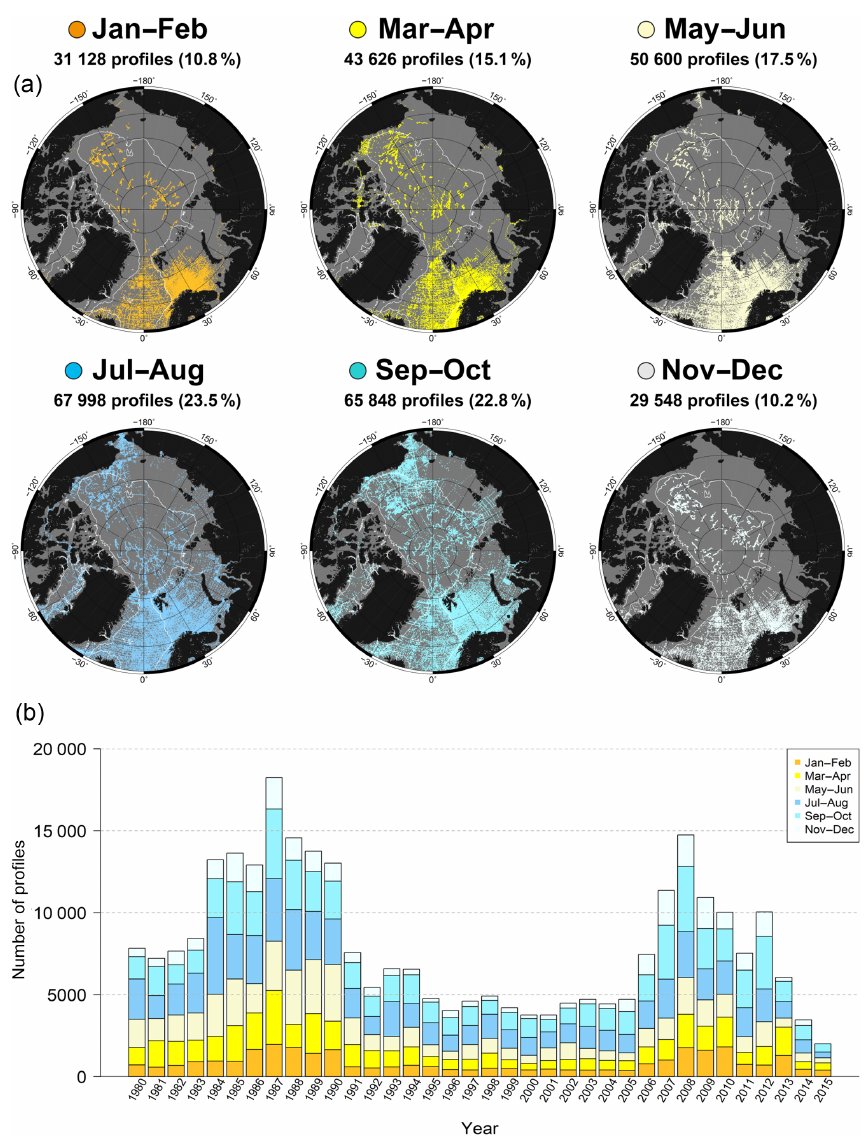
Figure 13. (a) Distribution maps of profiles in different 2-month periods. The white line is the 500m isobath. The fraction of the full data set is shown as percentage in brackets behind the respective number of profiles per period. (b) Number of profiles per year, measured in different 2-month periods